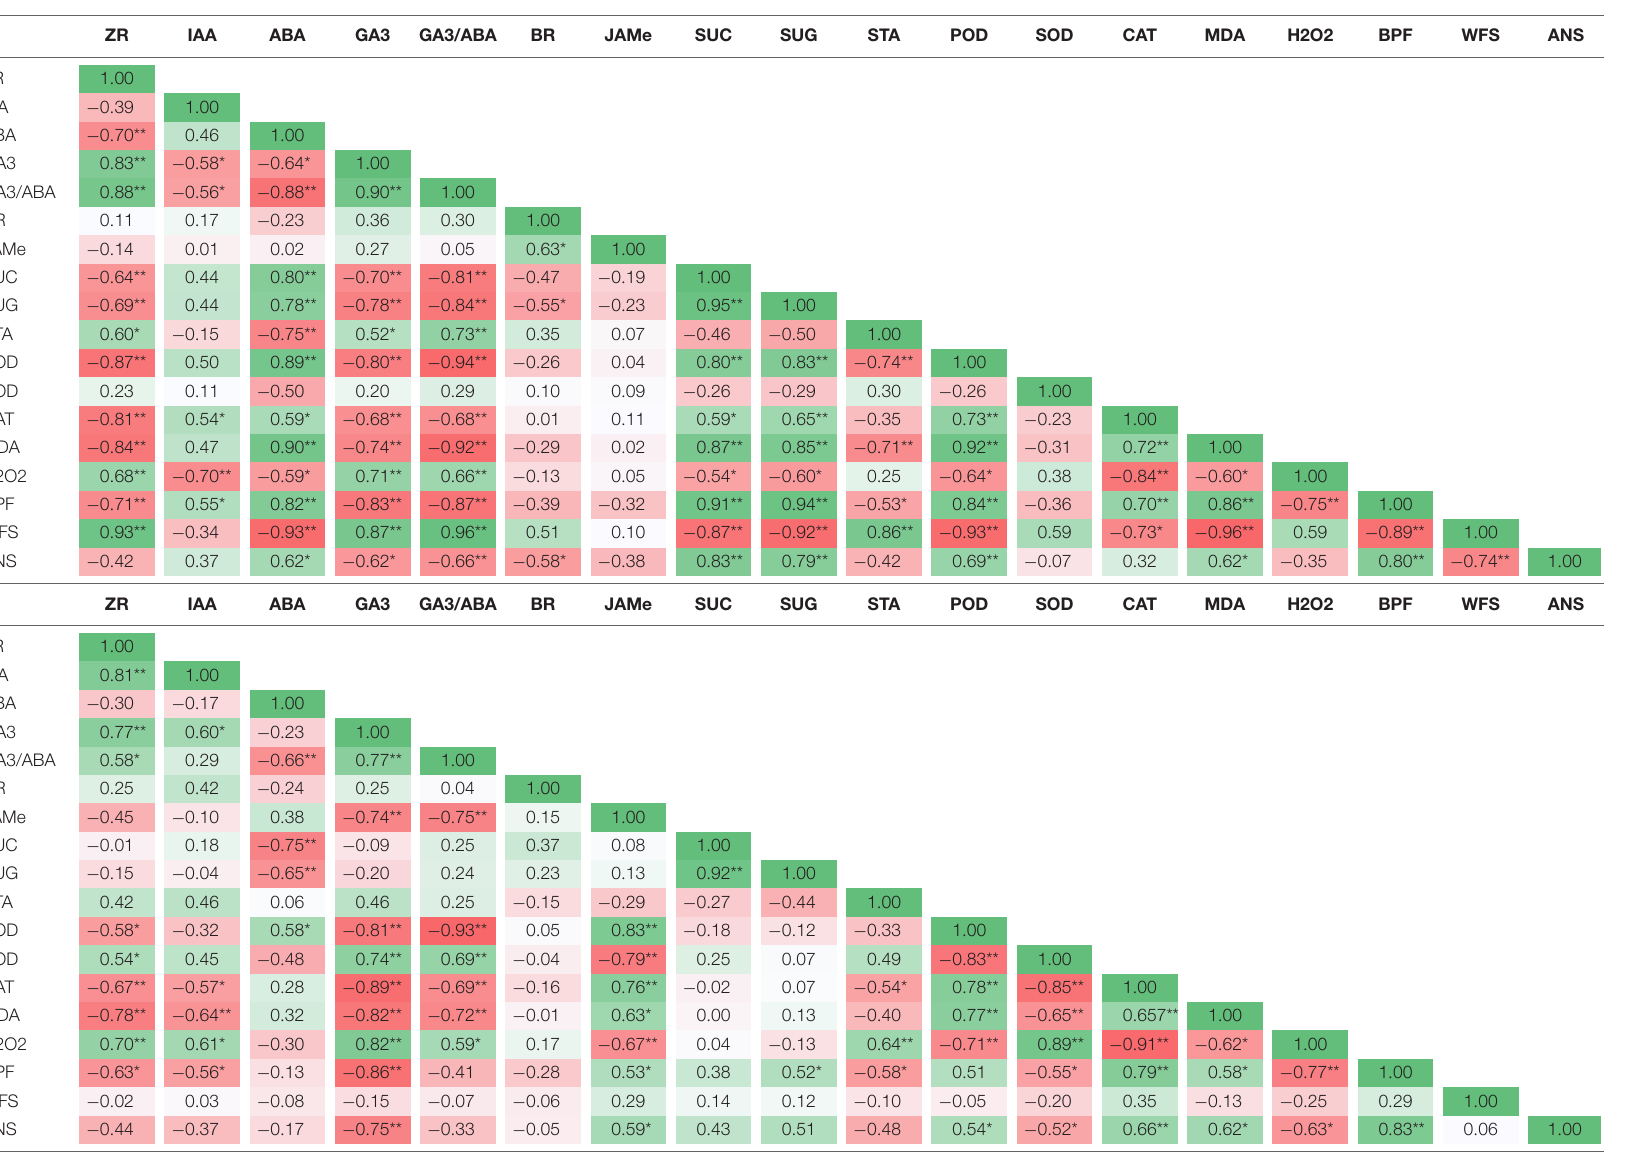
The symbol “**” indicates extreme significance (P < 0.01), and the symbol “*” represents significance (P < 0.05). The darker the background color is, the more significant the correlation is. Green indicates a positive correlation, and red indicates a negative correlation. H, ‘Hang Baishao’; Z, ‘Zhuguang’; ZR, zeatin riboside; IAA, indole-3-acetic acid; BR, brassinosteroid; JAMe, methyl jasmonate; SUC, sucrose; SUG, sugars; STA, starch. The other full names of the acronyms are shown in the main body of the article. The contents of IAA, ZR, BR and JAMe were shown in Supplementary Figure 2